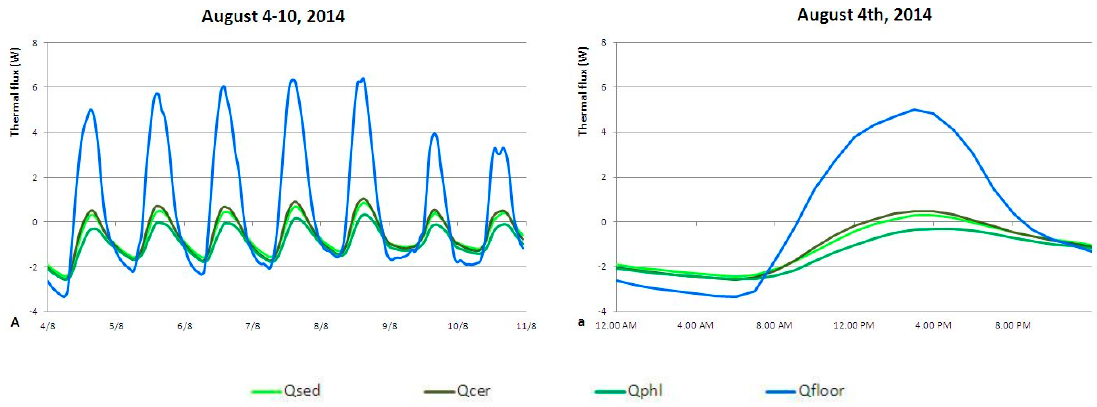
Figure 12. Analysis of summer heat flows: ( A ) sample week; ( a ) sample day.